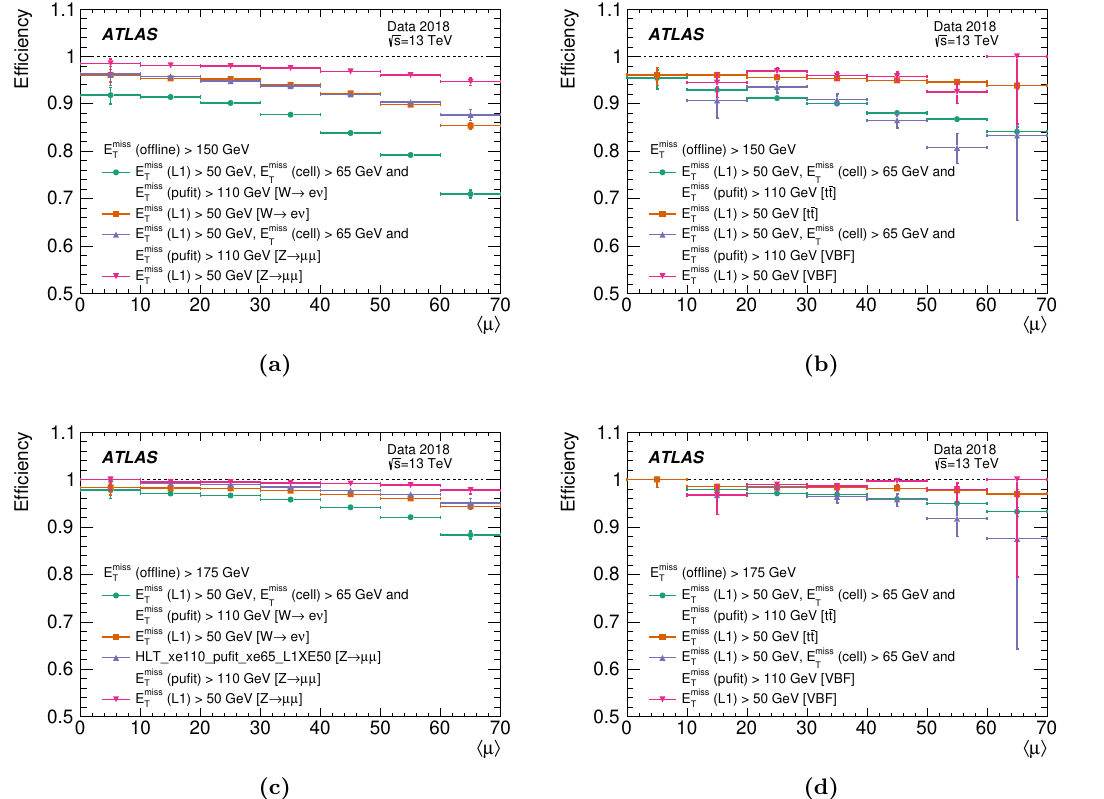
Figure 11. E(cid:14)ciencies for the (cid:12)rst-level trigger L1XE50 and the combined L1+HLT trigger chain HLT xe110 pufit xe65 L1XE50 in data recorded in the year 2018 are shown as a function of h (cid:22) i for two di(cid:11)erent o(cid:15)ine E miss